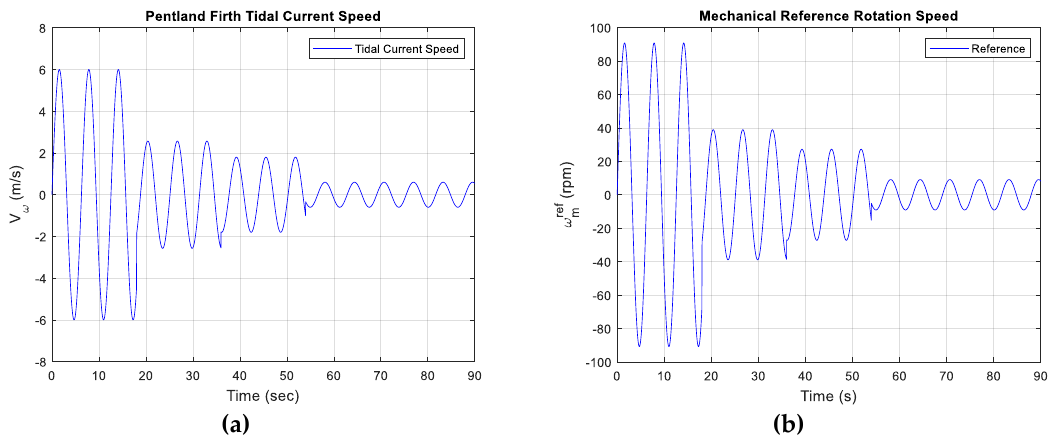
Figure 8. Input and reference signals. ( a ) Pentland Firth tidal current speed profile; ( b ) mechanical reference rotation speed by MPPT.